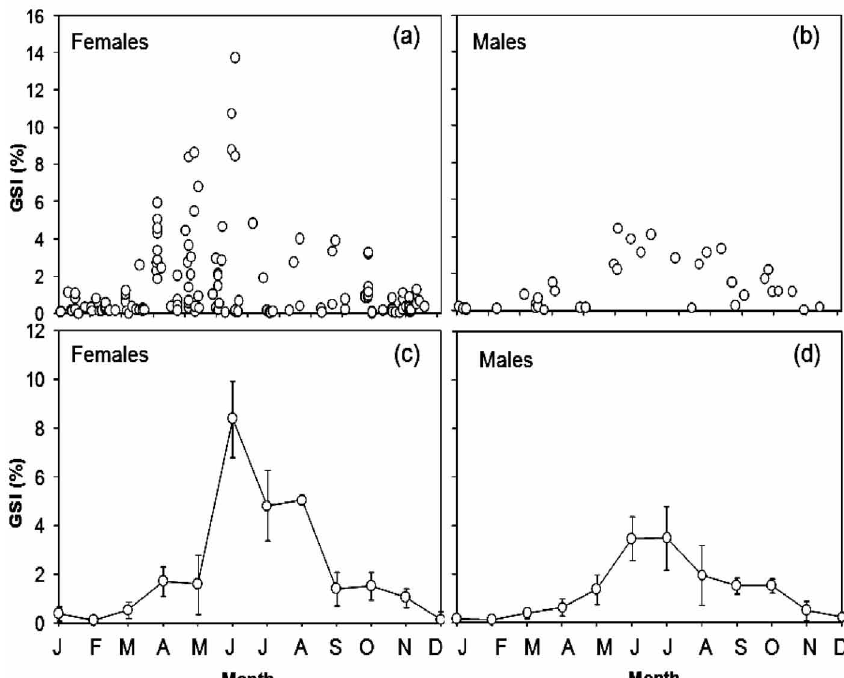
Fig . 5. – Individual and mean (± S.D.) gonadosomatic index values for females and males of Myteroperca fusca caught between January 2004 and December 2005 in waters of the Canary Islands. All calculated values of the index were grouped to show monthly variations over a single year.